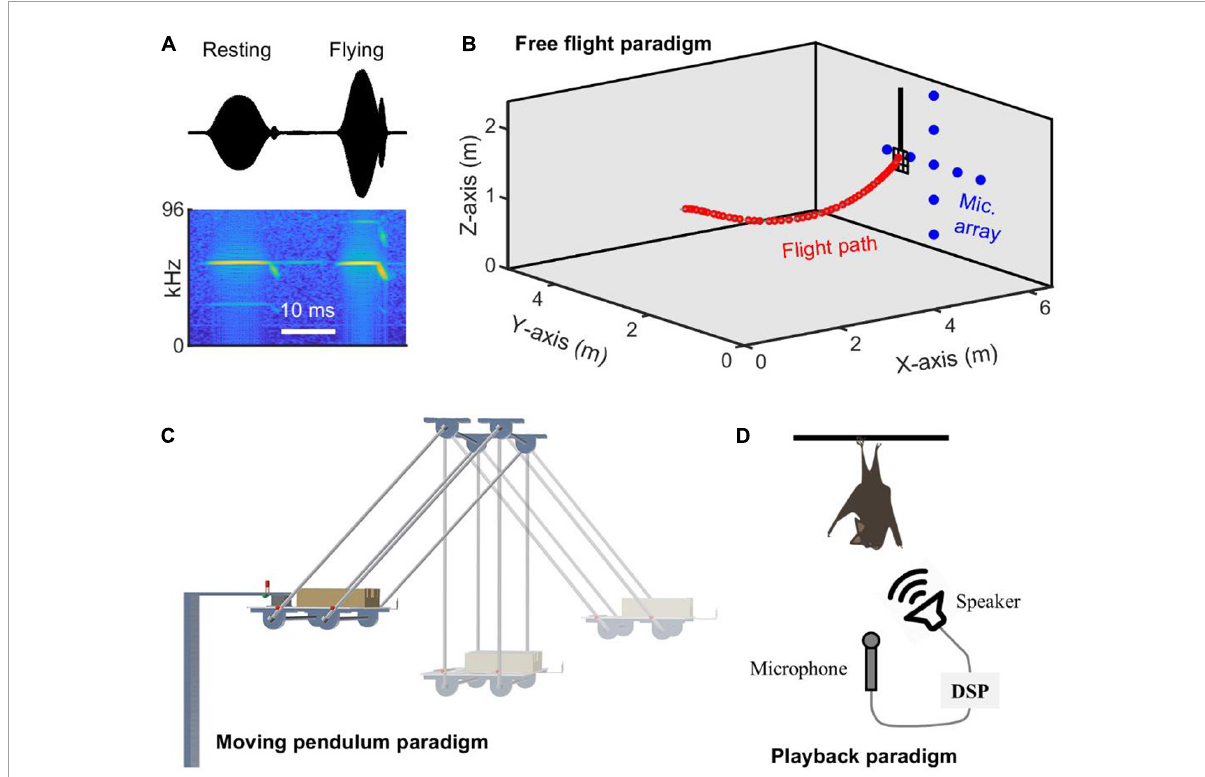
FIGURE1 Three typical experimental paradigms employed for quantifying Doppler shift compensation behavior in CF-FM echolocating bats. (A) Typical examples of echolocation calls produced by the CF-FM bat Hipposideros pratti when hanging freely and flying toward a landing platform. Note that the duration, as well as the energy distribution across harmonics, are different, with the call from the flying situation shorter in duration, weaker, and stronger in energy for the first and third harmonics, respectively. (B) Free flight paradigm, in which echolocation calls of a trained flying bat were recorded by an array of microphones mounted on the wall, and the flight path was reconstructed based on microphone recordings. (C) Moving pendulum paradigm, in which a body-restrained bat was swung back and forth, and the echolocation calls were recorded by an onboard microphone in front of the bat’s mouth. (D) Playback paradigm, in which a hanging (resting) bat spontaneously produces echolocation calls and receives a frequency-shifted copy of the calls online. In turn, bats may adjust the call frequency in response to frequency-altered auditory feedback. DSP, digital signal